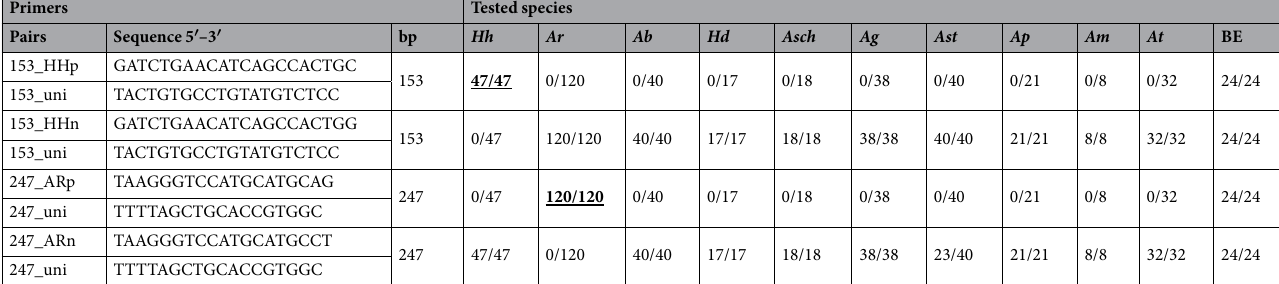
Table 1. Primers developed for identification of Huso huso and Acipenser ruthenus and validation tests of all primer pairs performed on nine sturgeon species and bester, hybrid of H . huso and A . ruthenus